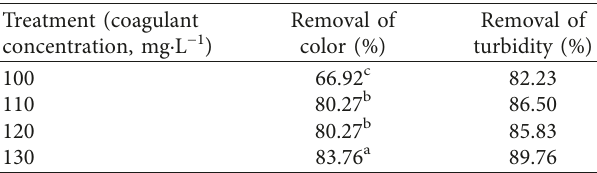
Figure 2: Response surface for removal (%) of color (a) and turbidity (b) and contour plots for the removal (%) of color (c) and turbidity (d) of the laundry wastewater by Tanfloc POP ® . Table 7: Removal of color and turbidity and comparison of means (Fisher’s LSD test) for the color